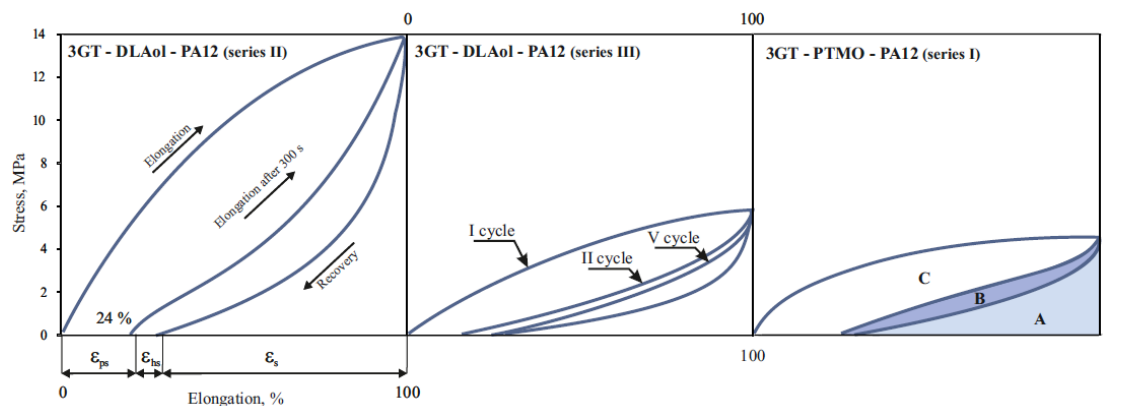
Figure 15. Strain–stress curves of TPEs.